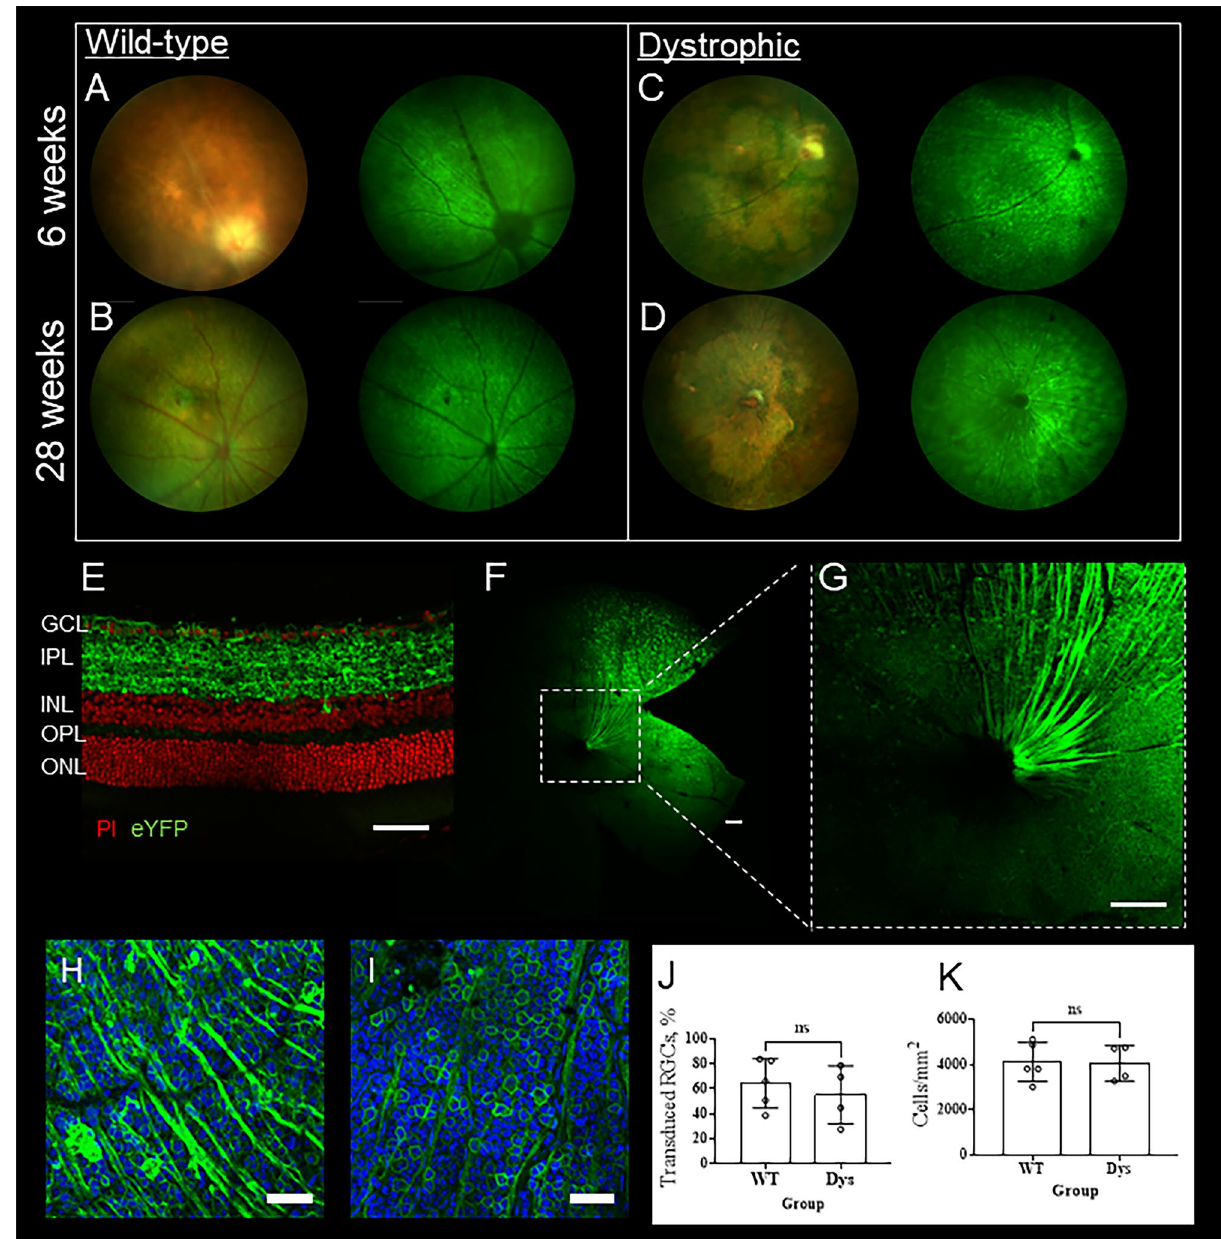
Figure 1. Prolonged expression of bReaChES in the retinal ganglion cells of wild-type (WT) and dystrophic (Dys) mouse retinae. ( A – D ) Representative fundus images (left: color, right: short-wavelength fluorescent fundus photography) of WT and dystrophic mice 6 ( A , C ) and 28 ( B , D ) weeks post-treatment. Green fluorescence indicates bReaChES-eYFP expression. ( E – H ) Representative WT retinal section (E) and flatmount ( F – G ) images that show membrane expression of bReaChES in GCL, IPL and nerve fibers. Representative retinal flatmounts from WT (H) and dystrophic ( I ) mouse retinae that show membrane expression of bReaChES in individual retinal ganglion cells. ( J ) The transduction rate of optogenetic vector in RGL is not significantly different between WT and Dys mice 6 months post injection (N = 5 WT and N = 4 Dys). ( K ) The density of RGL measured is not significantly different between WT and Dys mice 6 months post injection (N = 5 WT and N = 4 Dys). Error bars indicate ± SD. White scale bar = 50um. (Abbreviations: eYFP = enhanced yellow fluorescence protein; PI = propidium iodide; GCL = ganglion cell layer; IPL = inner plexiform layer; INL = inner nuclear layer; OPL = outer plexiform layer; ONL = outer nuclear